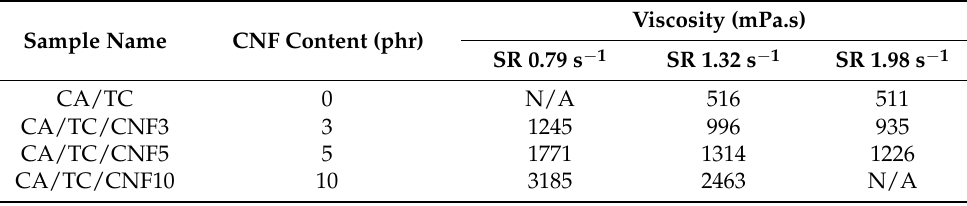
Table 2. Viscosity of CA/TC and CA/TC/CNF solutions in NMP with different CNF content and shear rate at a concentration of 10 wt%.